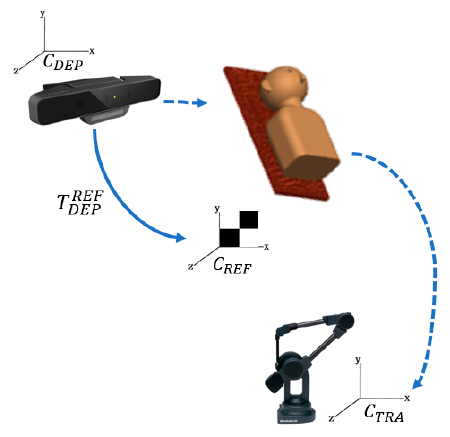
Figure 11. Diagram of the computation of coordinate conversion validation errors.